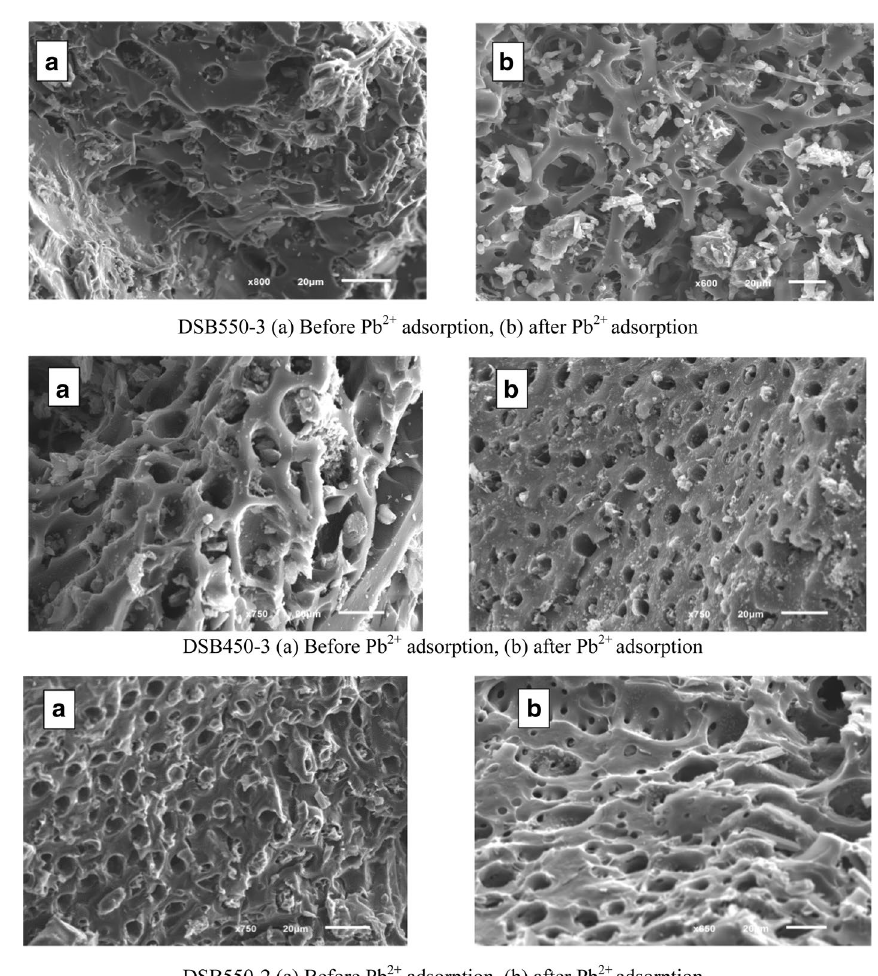
Fig. 2 SEM images for DSB550-3 biochar before and after Pb 2+